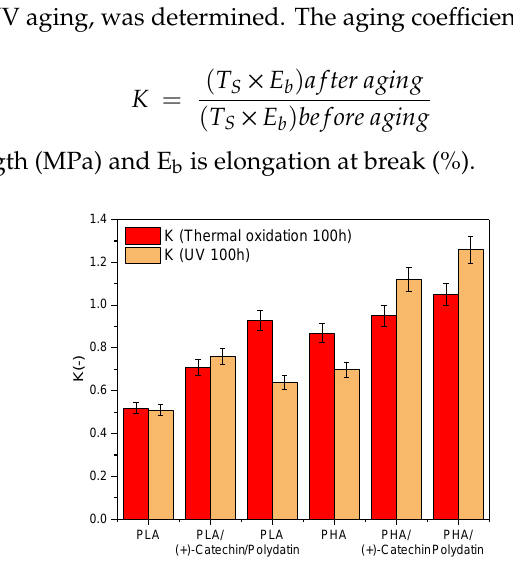
Table 1. Mechanical properties of polylactide (PLA) and polyhydroxyalkanoate (PHA) samples with natural polyphenols. T Fmax , the maximum stress transferred by the sample (MPa); E Fmax , the maximum elongation of the sample at break (%); T S , the tensile strength (MPa); and E, the elongation at break (%).